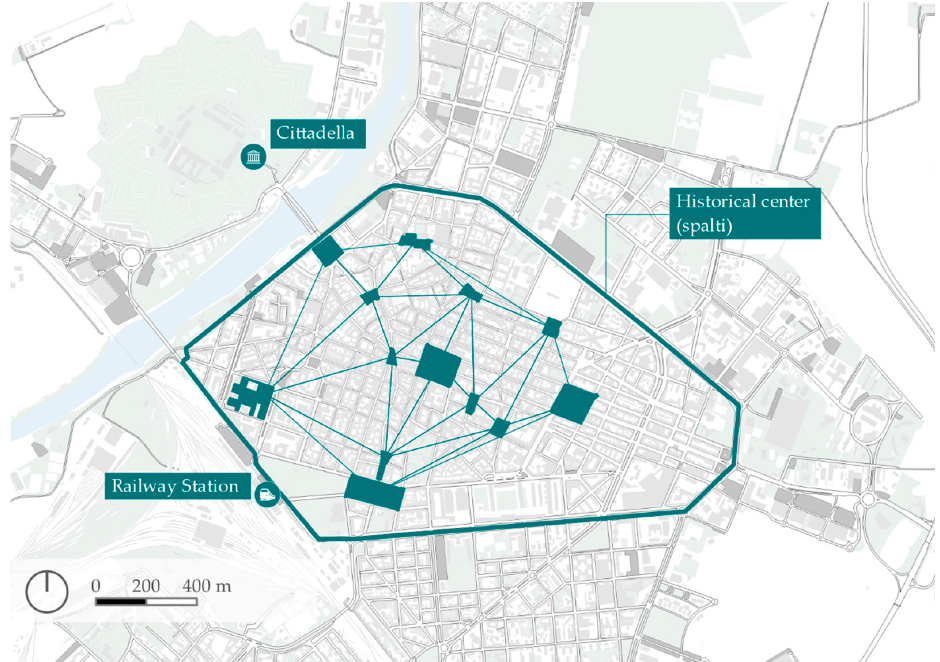
Figure 2. The 13 selected squares are located in both the inner part of the historical center and on its boundaries, and they include different kinds of spaces, from the oldest historical squares to places that are not even proper squares, but a system of parking areas [Sources: Authors, OpenStreetMap, Municipality of Alessandria].